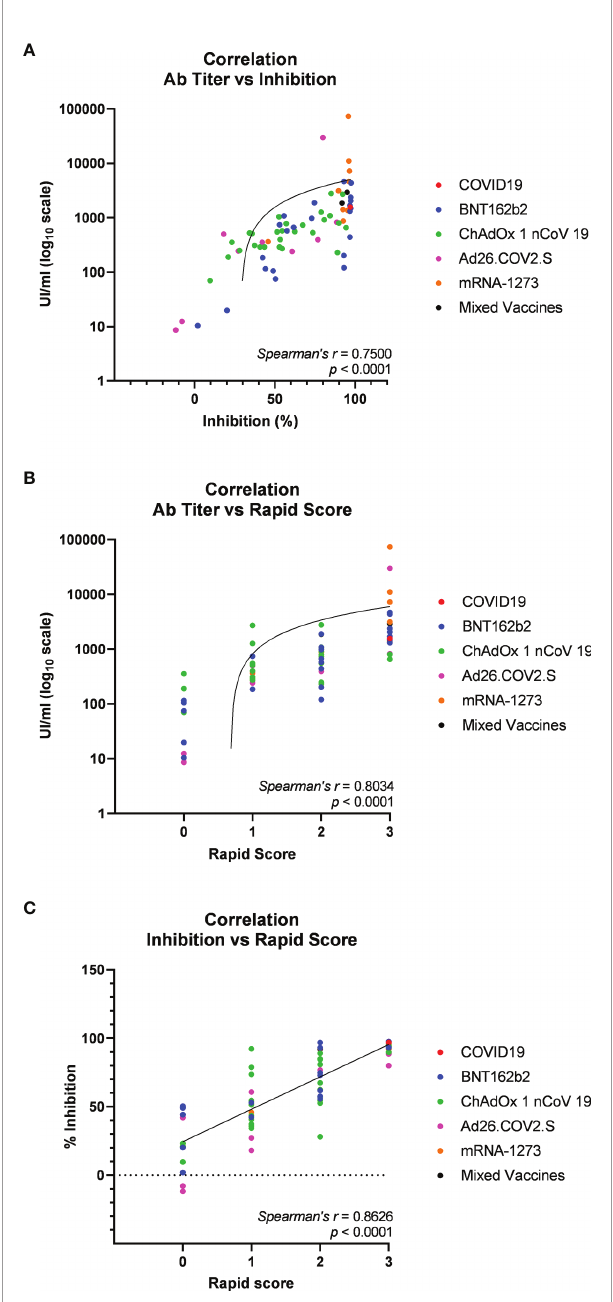
FIGURE 2 | Spearman ’ s correlation analysis of serum anti-receptor-binding domain (anti-RBD) antibody titers and neutralizing activity in 70 participants in the study (22 vaccinated with BNT162b2, 9 with mRNA-1273, 27 with ChAdOx1 nCov19, 9 with Ad26.COV2.S, 1 COVID-19 convalescent, and 2 with mixed vaccines). (A) Correlation plot of anti-RBD antibody titers versus neutralizing activity (percentage inhibition of RBD-ACE2 binding) assessed through the cPass ™ ELISA-based assay. (B) Correlation plot of anti-RBD antibody titers versus neutralizing activity assessed through IgG/Neutralizing Antibody Rapid Test. (C) Correlation plot of neutralizing activity evaluated through cPass ™ ELISA-based assay and IgG/Neutralizing Antibody Rapid Test cassettes. Trendlines, Spearman ’ s r , and p -values are also represented (statistical signi fi cance for p <